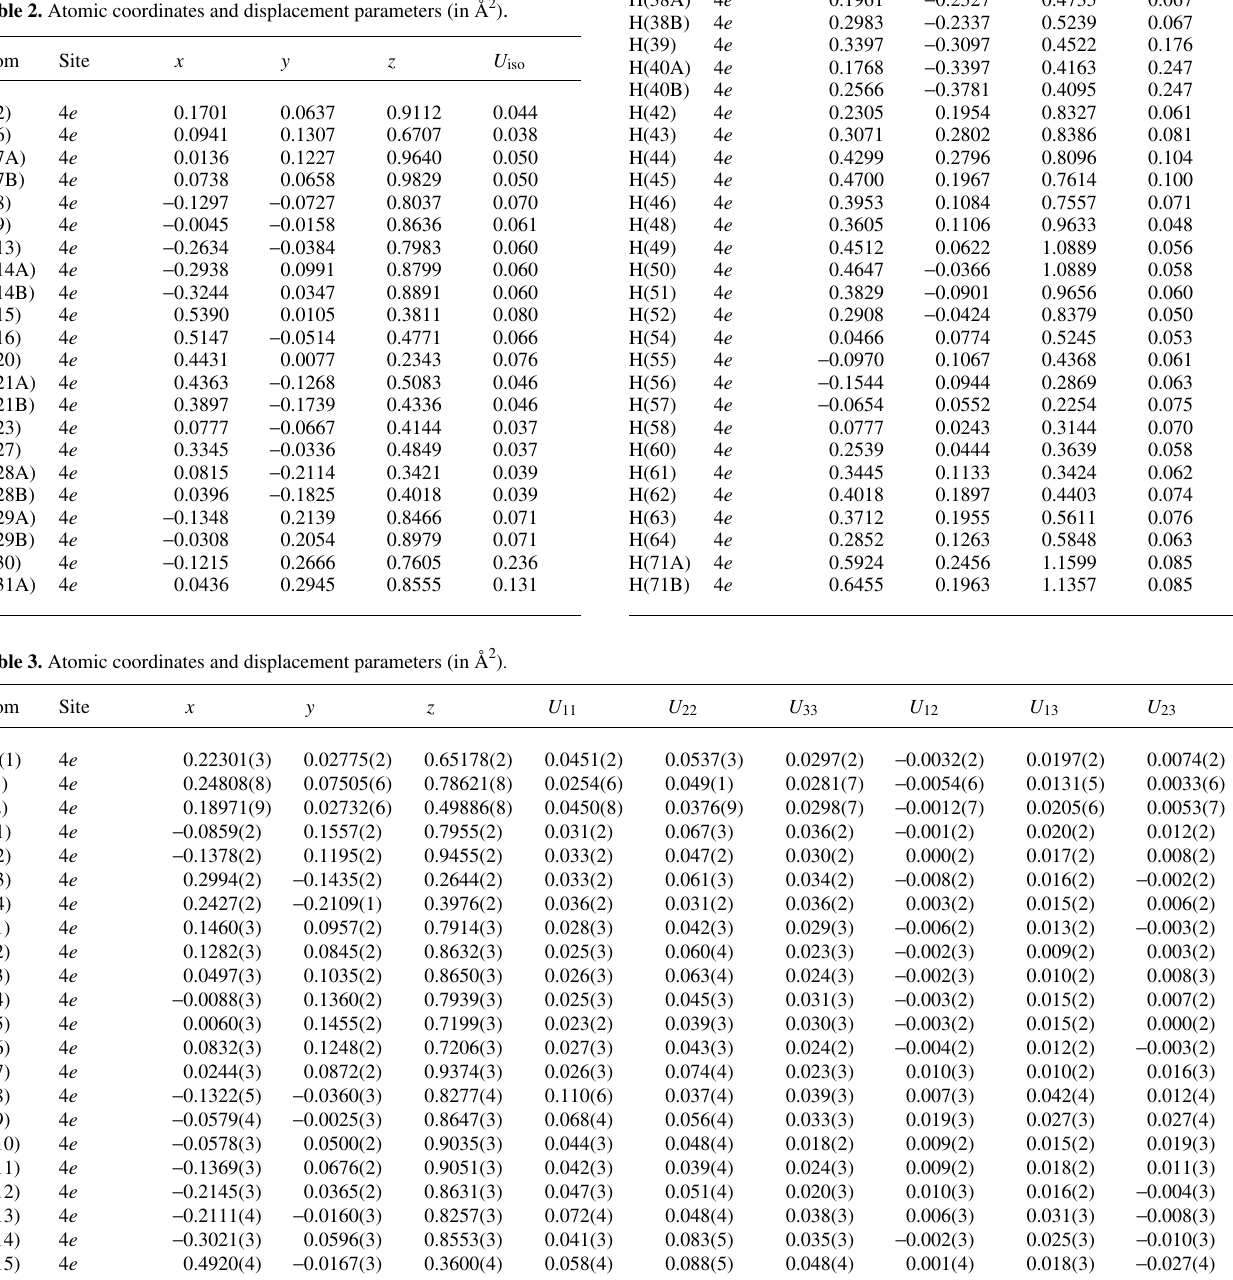
Table 2. Atomic coordinates and displacement parameters (in Å 2 ) .